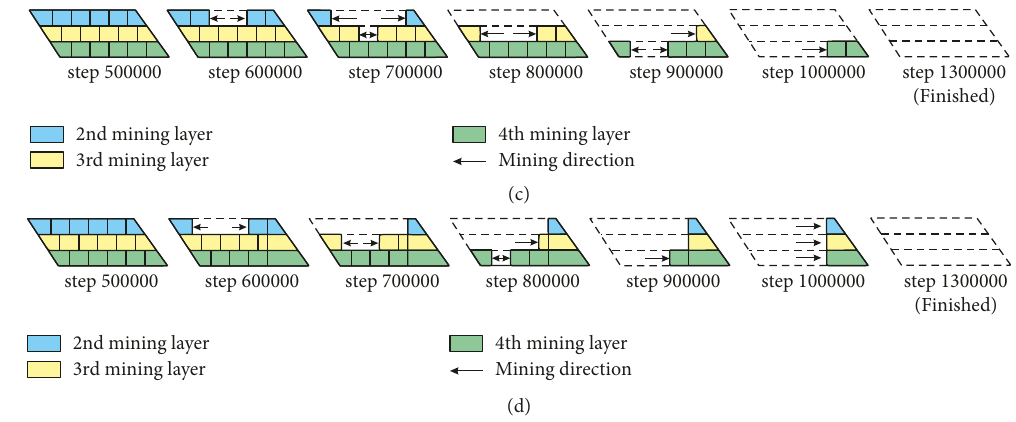
Figure 15: Four mining scenarios with different mining sequences. (a) Scenario 1, (b) Scenario 2, (c) Scenario 3, (d) Scenario